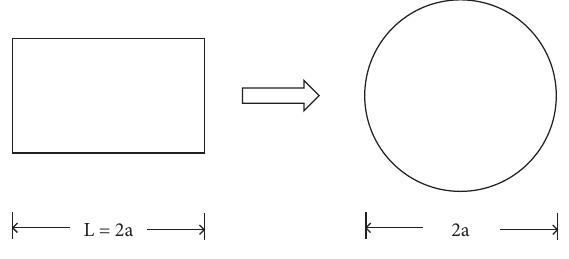
Figure 6: Structure diagram of circular MSA.